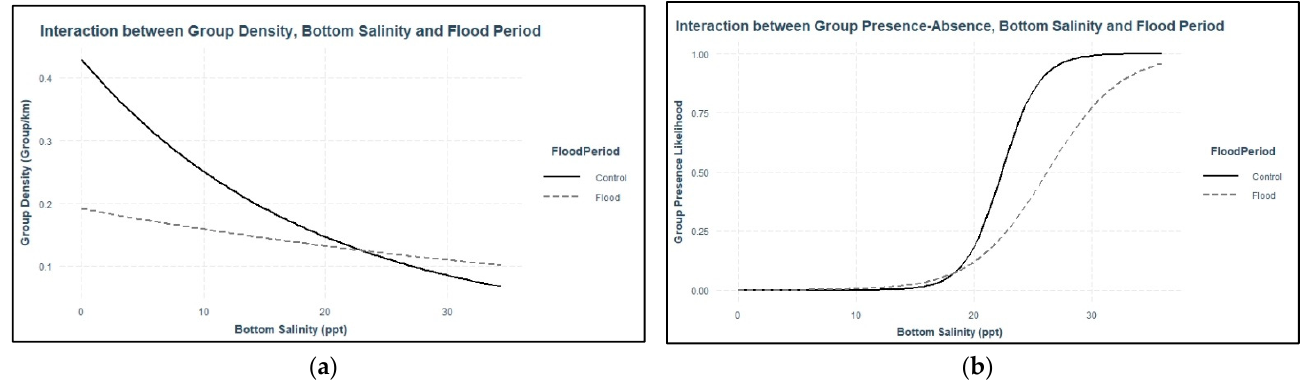
Figure 5. Interaction plots of: ( a ) presence-only dolphin group density, bottom salinity, and flood period; ( b ) dolphin group presence–absence, bottom salinity, and flood period. Interaction plots were created in R [37] using the ‘interactions’ package [40].